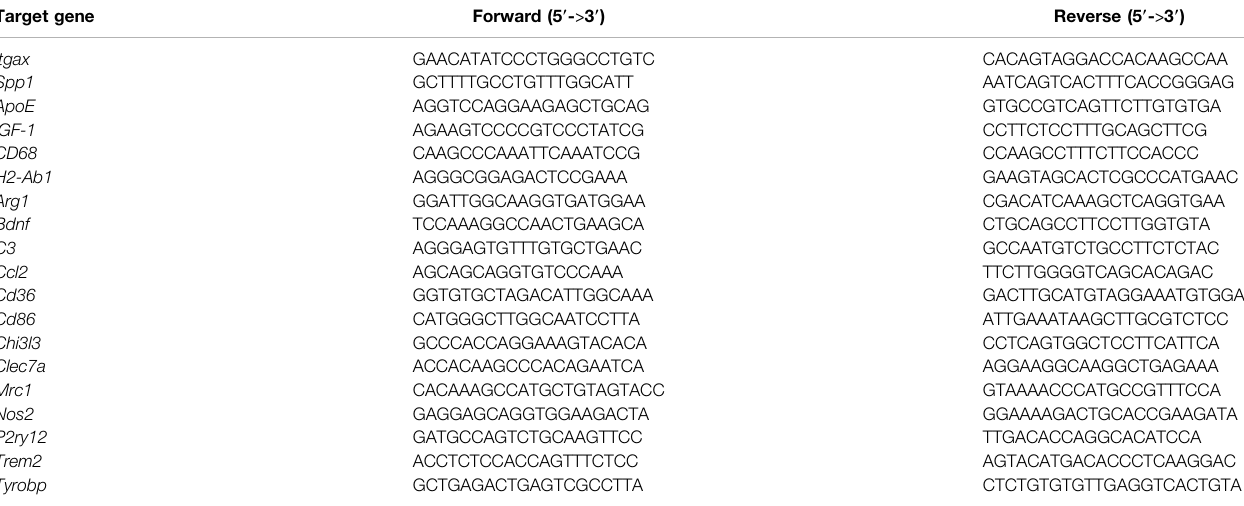
TABLE 1 | Sequences for mouse primers used for qPCR. Target